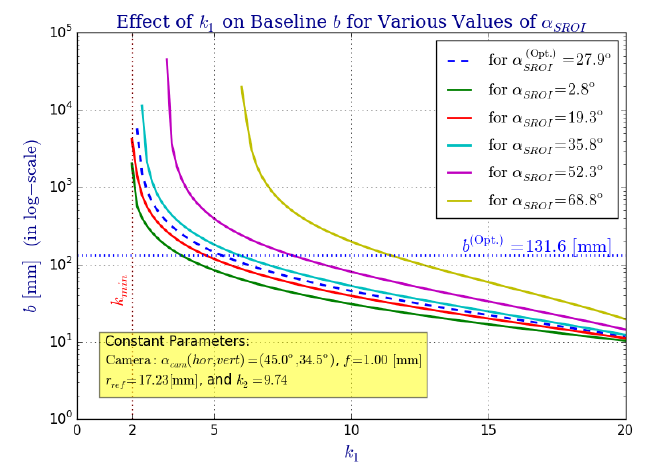
Figure 10. The effect that parameter k 1 has over the omnistereo system’s baseline b for several common FOV angles ( α SROI ) and a fixed camera with α cam . An inverse relationship exists between k and b as plotted here (using a logarithmic scale for the vertical axis). Intuitively, the flatter the mirror gets ( k → 2), the farther F 1 must be translated in order to fit within the camera’s view, α SROI , causing b to